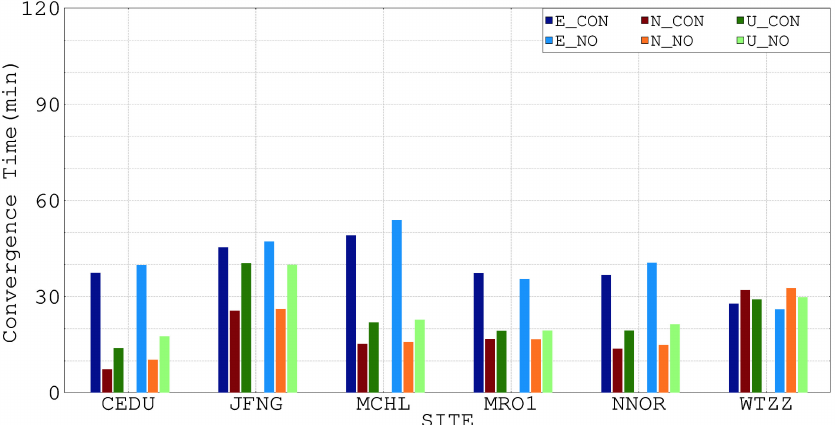
Figure 19. Mean convergence time of six stations for the BDS-2 / 3 static PPP from DOY 091 to 110, 2020.